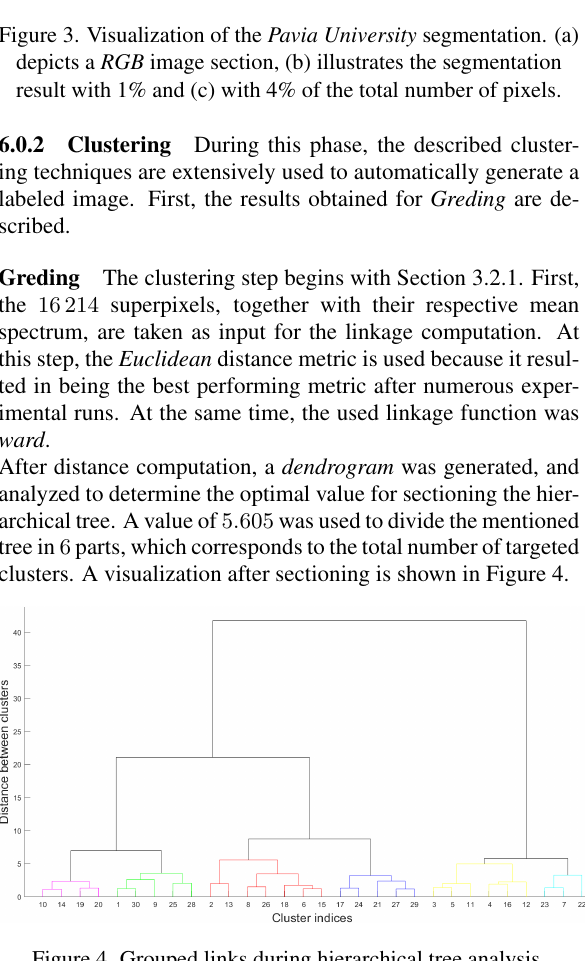
Figure 4. Grouped links during hierarchical tree